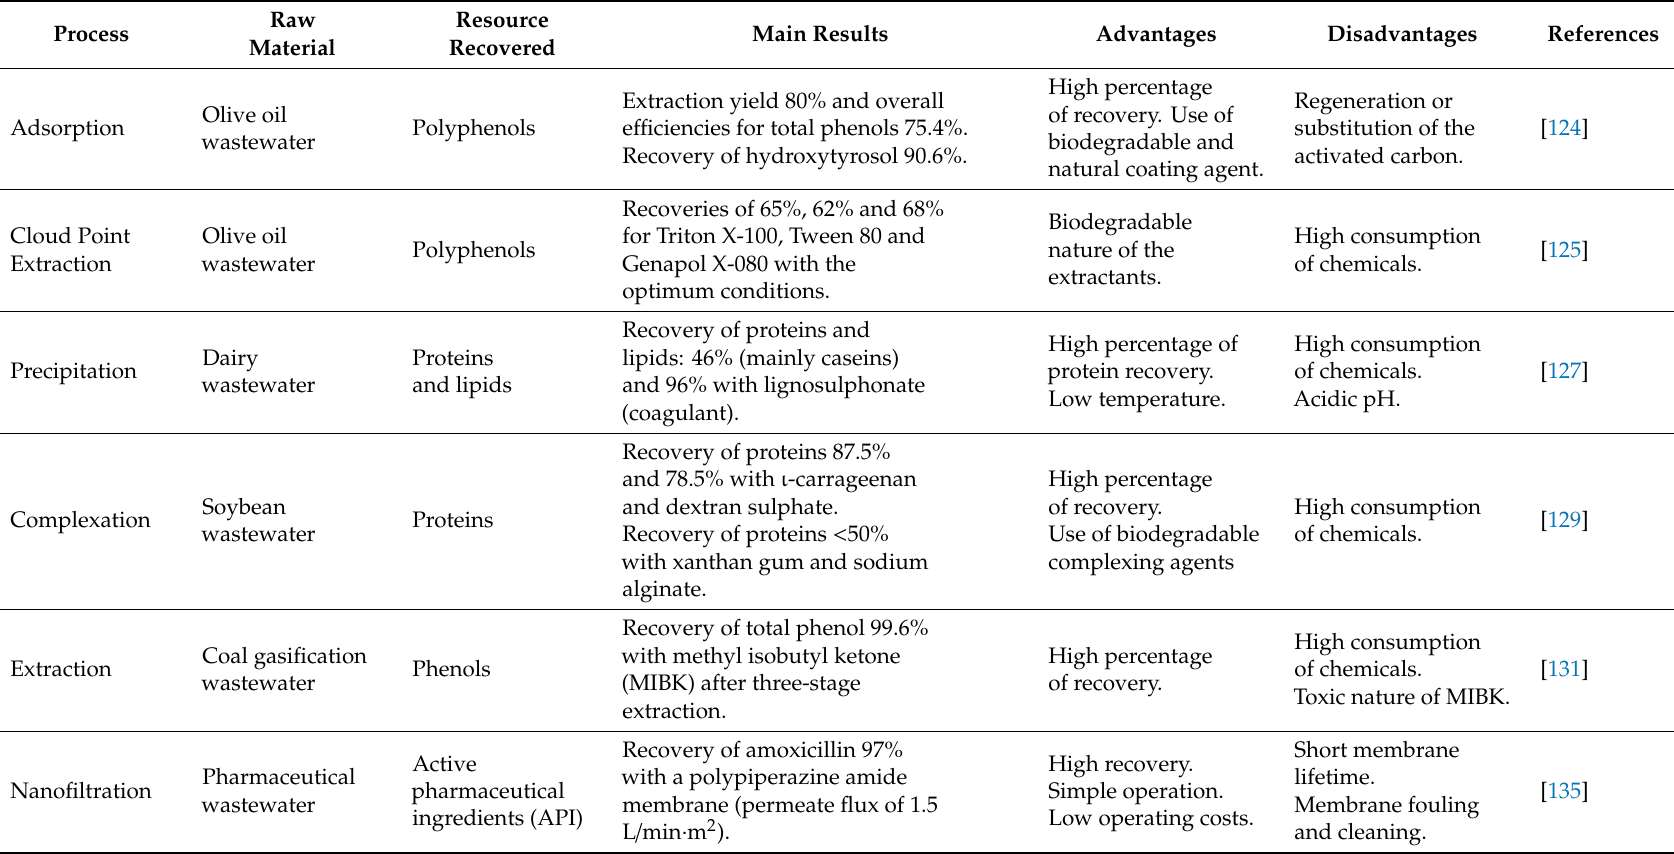
Table 5. Process employed for the recovery of high-value added products from industrial